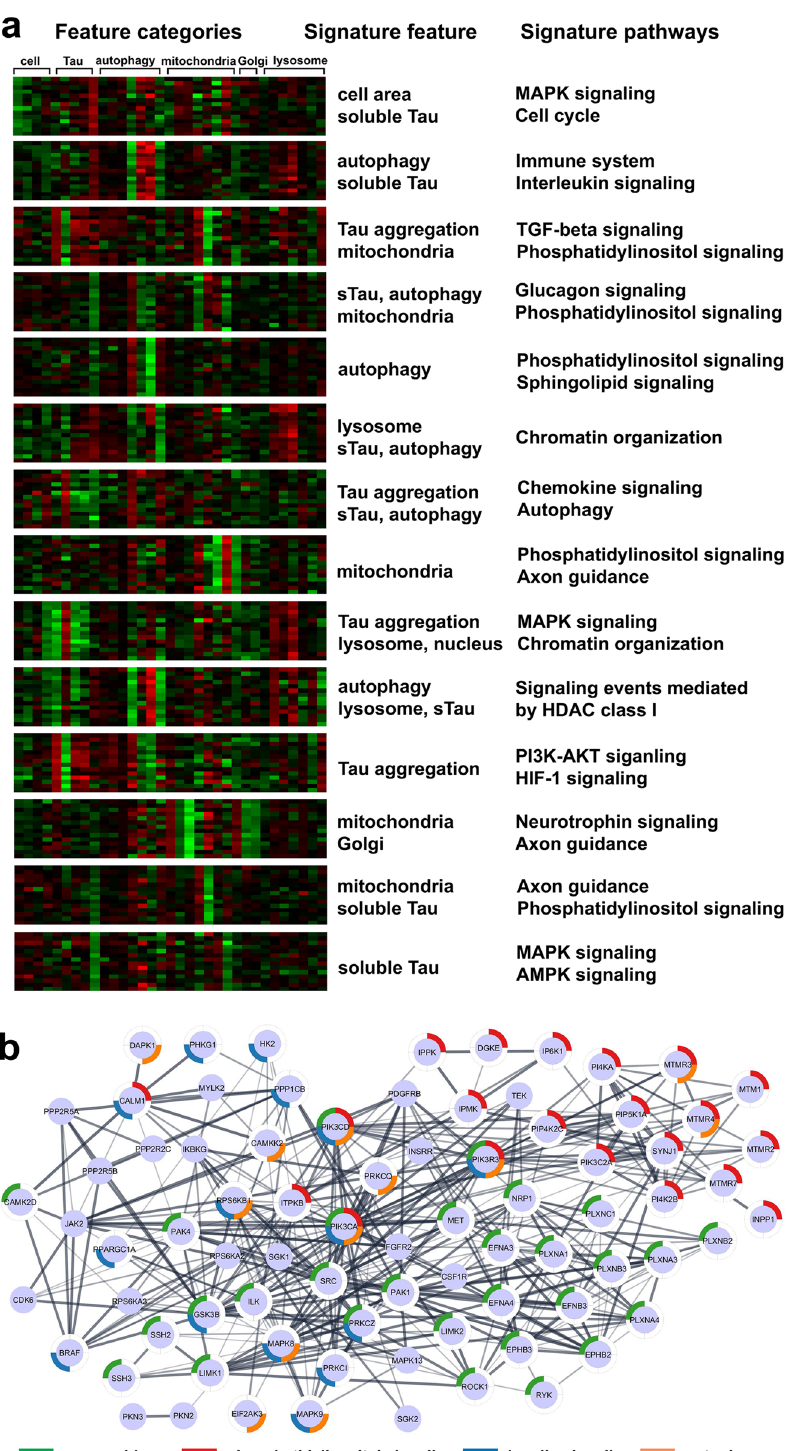
Figure 6. Gene function inference and pathway interactions revealed by signature cellular features. ( a ) Heatmap illustration of k-means clustering of screened genes based on 33 cellular features that capture general cell morphology and health, tau, autophagy, mitochondria, Golgi, and lysosome. The 14 clusters show dominant perturbed cellular processes and are associated with signature enriched pathways. Enriched pathway FDR q-value < 0.05. ( b ) Cytoscape STRING network of genes and pathways that affect mitochondrial morphology. Outer ring highlight network enriched pathway. STRING interaction evidence included experiments and